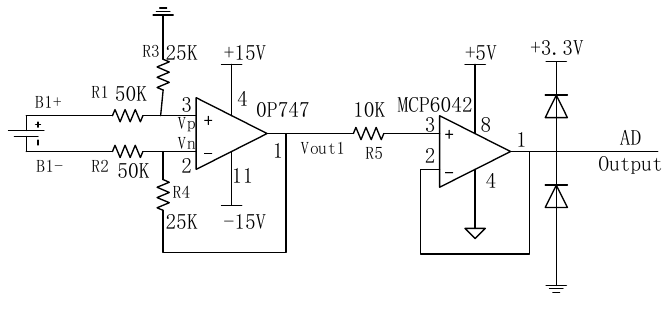
Figure 15. Voltage-sampling circuit.